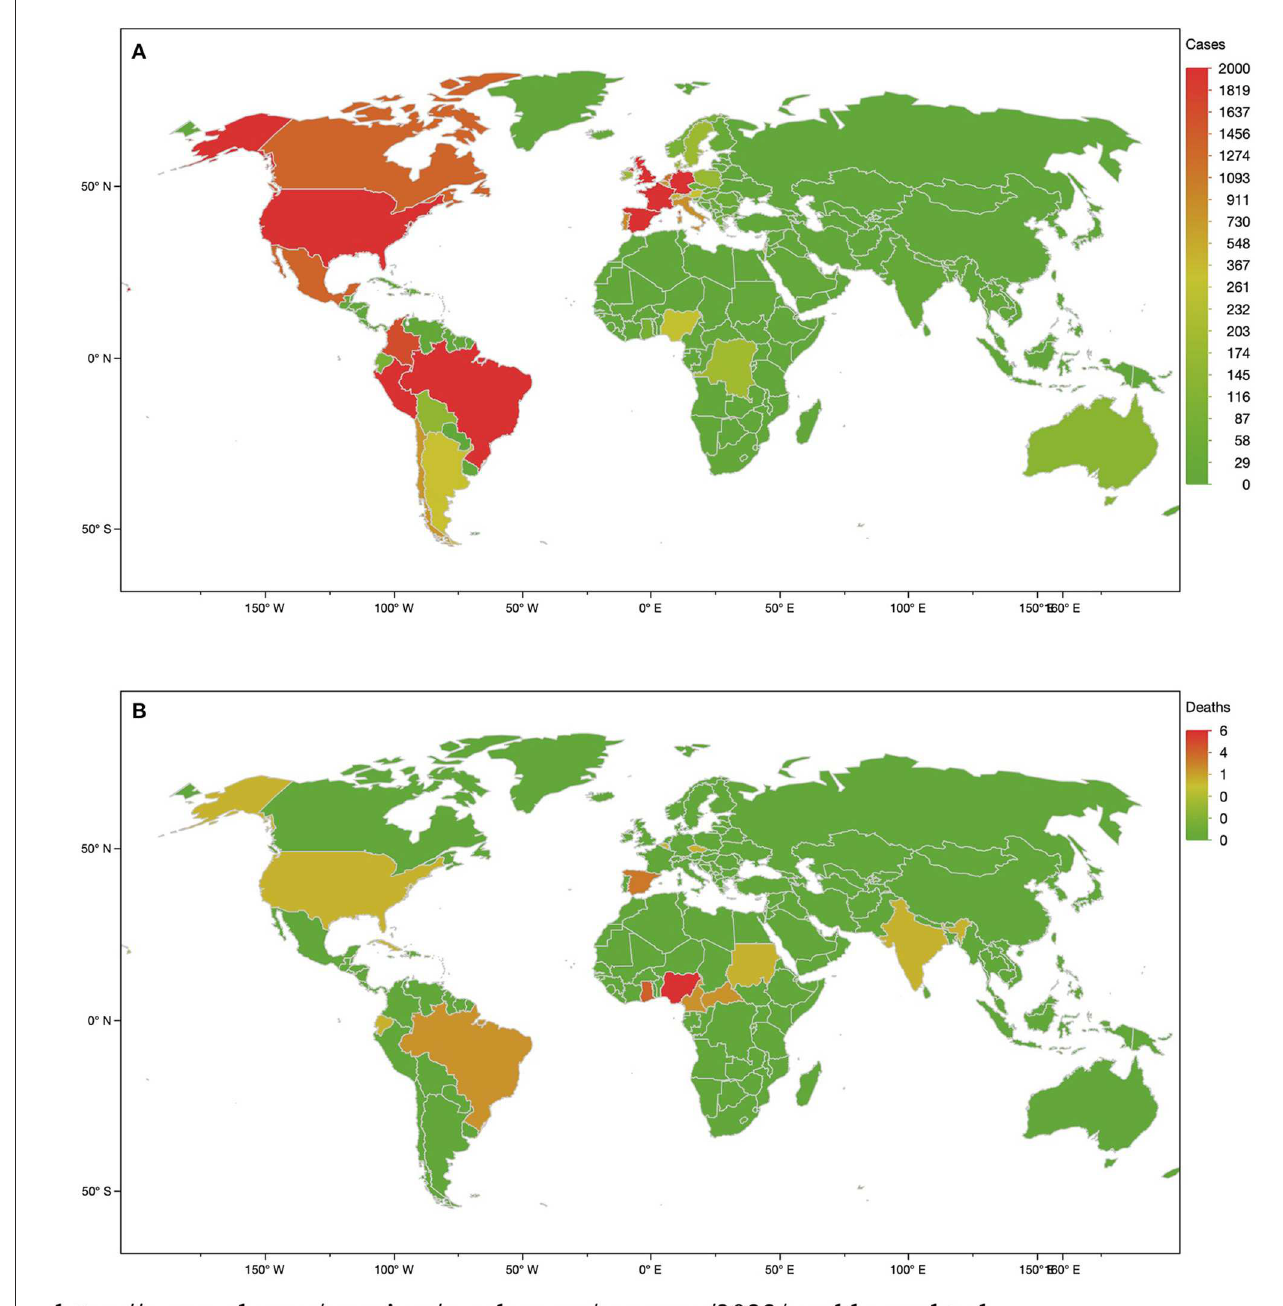
FIGURE1 Number of monkeypox virus (MPXV) cases (A) and deaths (B) at the date of 23th September, 2022.